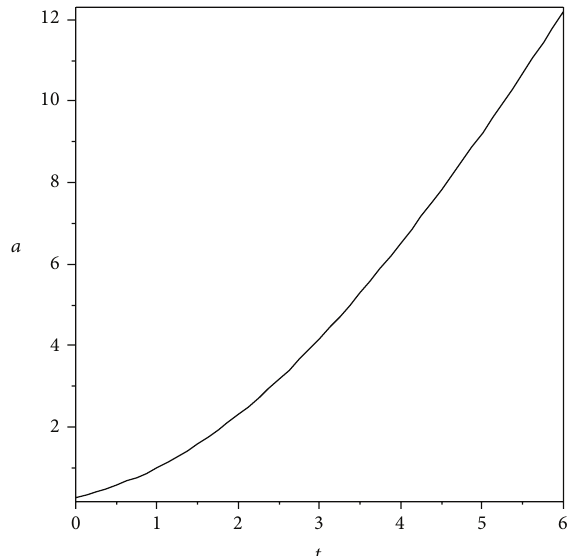
Figure 5: Variation of scale factor 𝑎(𝑡) for different values of 𝑡 for 𝑛 = 3 , 𝜁 = −2 and 𝑚 = −0.1 . The values of 𝜁 are determined by relation